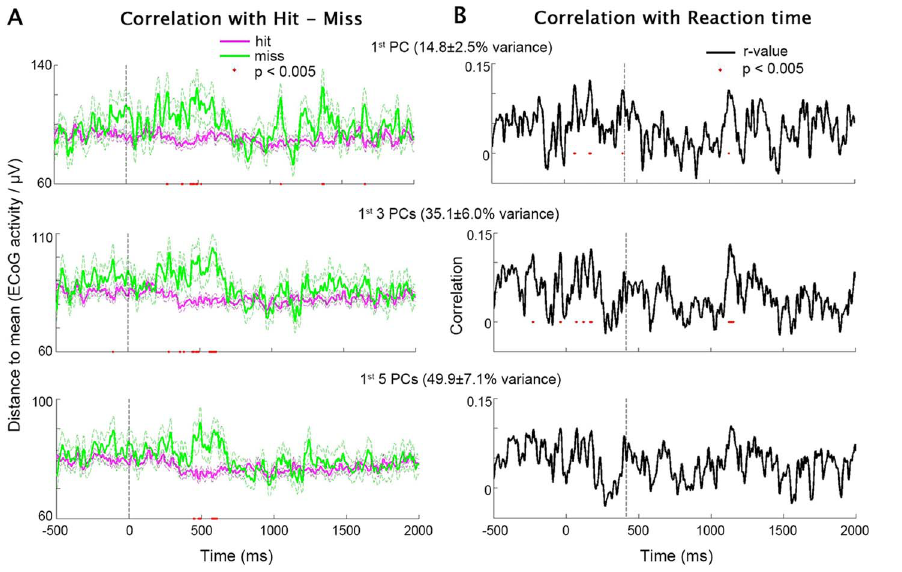
Figure 5. PCA test of the Inverted-U hypothesis using ipsilateral data. ( A and B ) same as in Figure 4, except results were obtained using ipsilateral